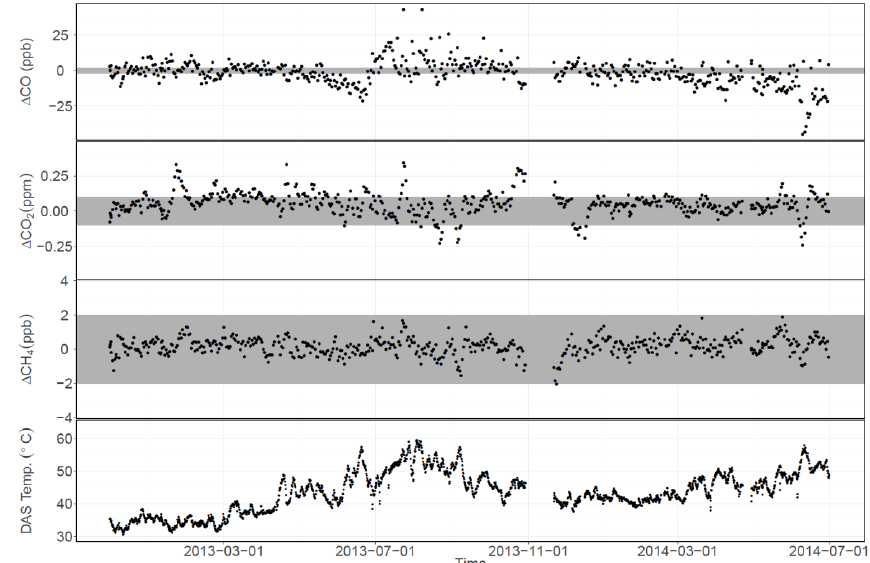
Figure 7. Absolute difference between span-calibrated target gas measurements with and without correction for temperature effects (i.e., span-calibrated without any correction – the multiple regression approach corrected and span-calibrated measurements). The grey shaded region represents the WMO interlaboratory compatibility target for CO, CO 2 , and CH 4 measurements. The bottom panel shows the analyzer’s DAS temperature during the measurement